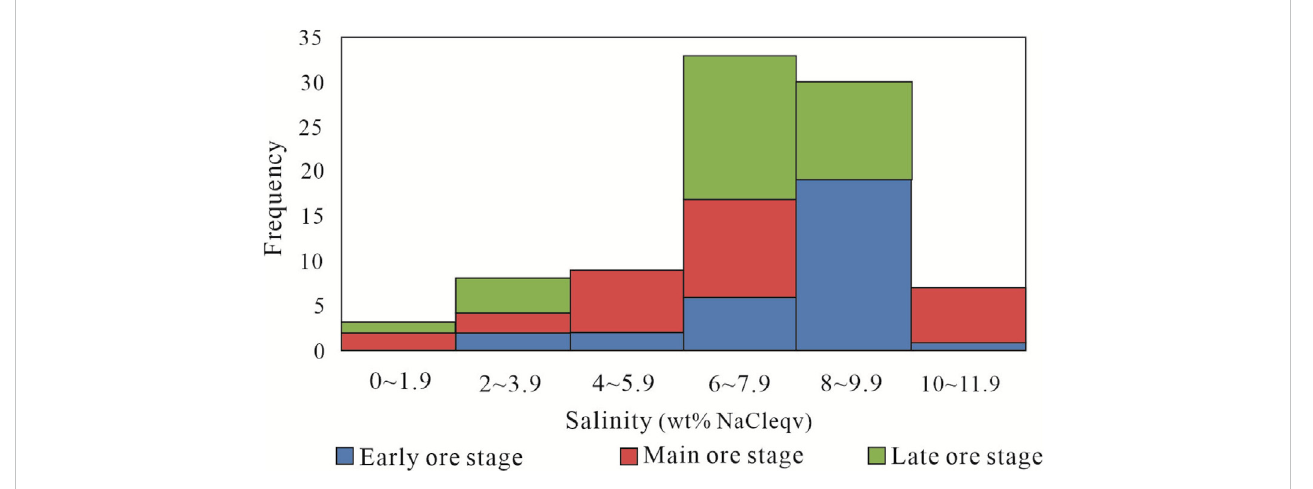
FIGURE 9 Salinity distribution histogram of fl uid inclusions from the different metallogenic stages at